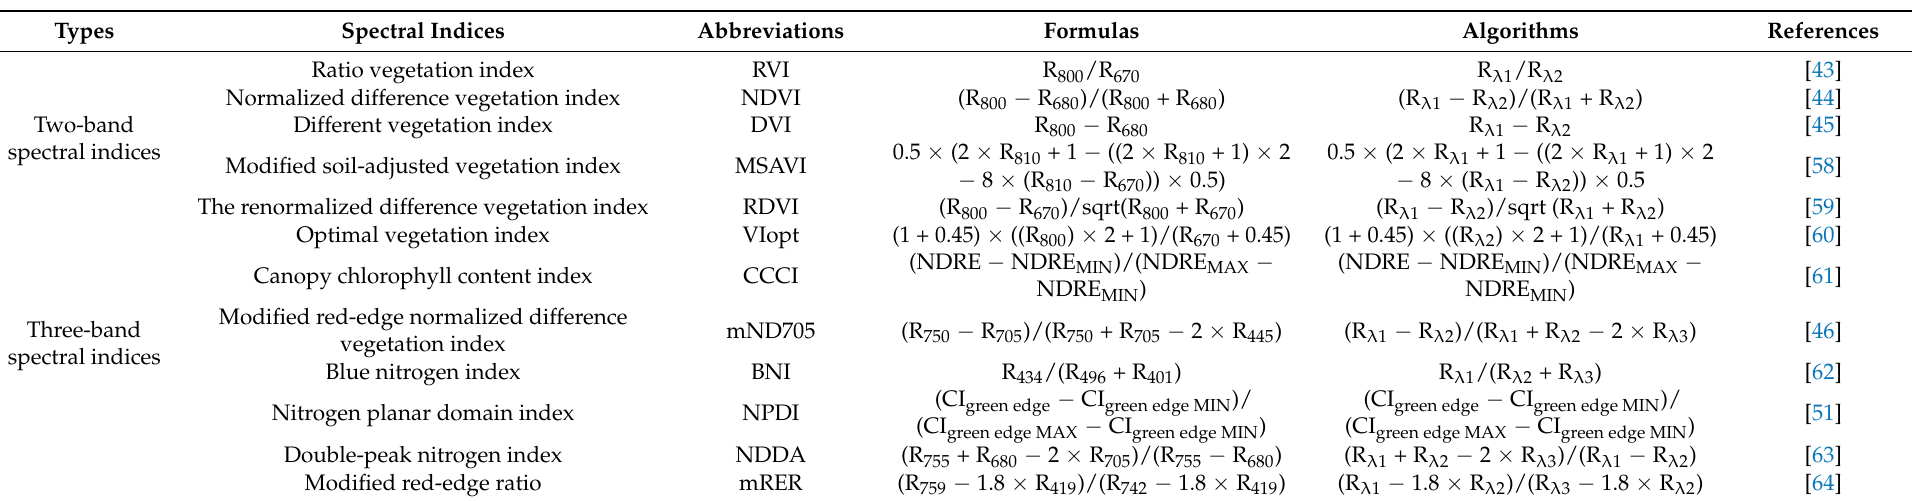
Table 1. Spectral indices used in this study.